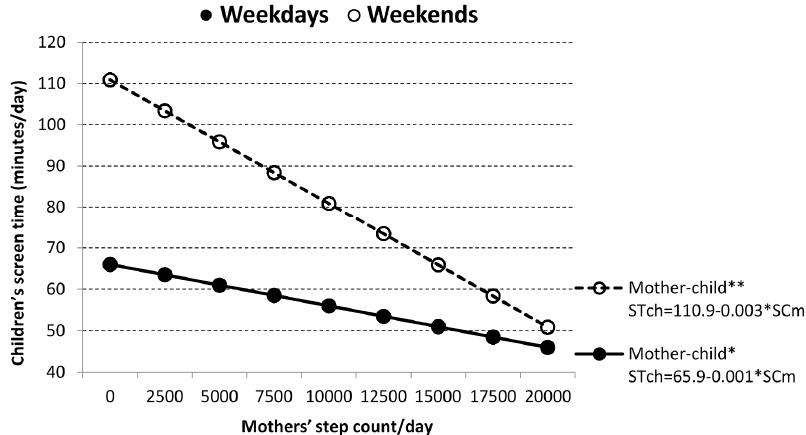
Figure 2. Relationship between parents’ and children’s daily screen time (ST). STch—screen time